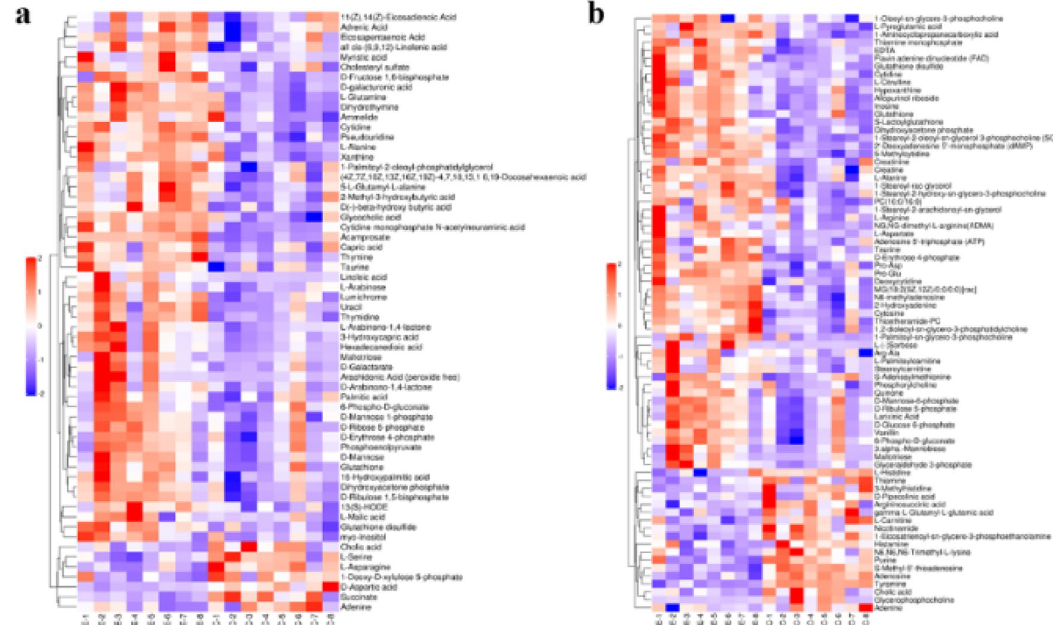
Figure 7. Hierarchical clustering of significantly differential Metabolites in rat myocardial samples. ( a ) Negative ions in group C/E; ( b ) positive ions in group C/E.